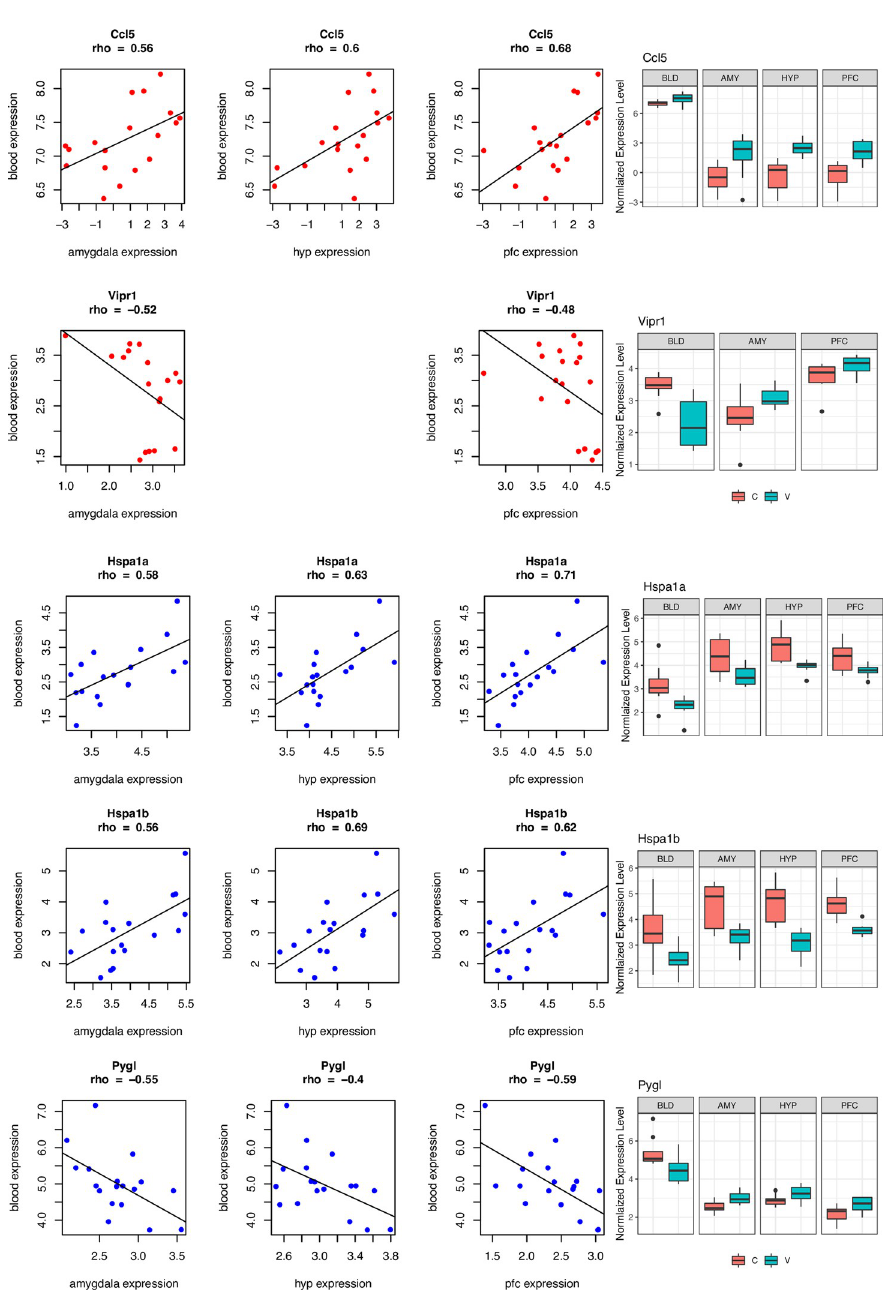
Fig 4. Genes with Expression Levels that are Correlated between Blood and Brain in C57BL/6J Mice. The scatterplots show the relationship between gene expression levels in blood (y-axis) and each brain area (x-axis). Each point in the scatterplot is a subject. Some correlated genes were also differentially expressed between CIE (V = ethanol vapor) and Air (C = control) mice in both blood and brain, which could make them ideal biomarker candidates. For females, Ccl5 was correlated and differentially expressed in blood and all brain regions. For males, Hsp1a and Hsp1b were correlated and differentially expressed in blood and all brain regions. The correlation coefficient is shown under the gene name. The boxplots show the normalized gene expression levels by